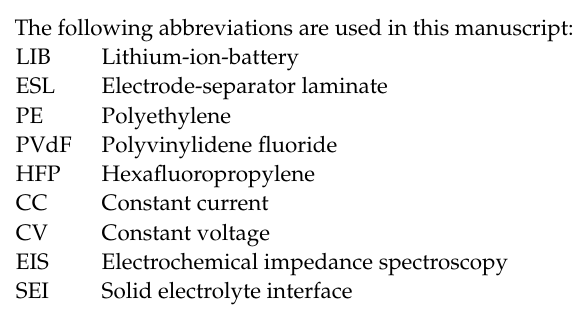
Figure S3: Additional resistance fit parameters of equivalent circuit fit analysis of EIS measurements, collected for NMC 622—graphite single cells with coated ceramic separator, comparing non-laminated and electrospun/laminated state. Figure S4: Capacitance fit parameters of equivalent circuit fit analy- sis of EIS measurements, collected for NMC 622—graphite single cells with coated ceramic separator, comparing non-laminated and electrospun/laminated state. Figure S5: CPE exponent fit parameters of equivalent circuit fit analysis of EIS measurements, collected for NMC 622—graphite single cells with coated ceramic separator, comparing non-laminated and electrospun/laminated